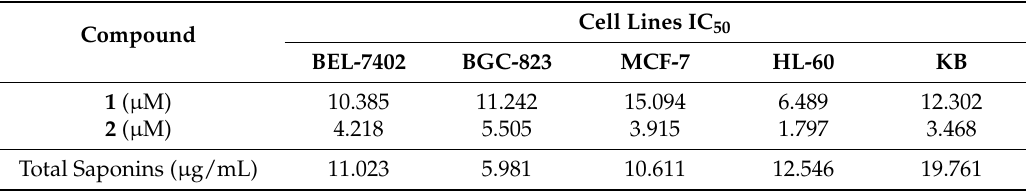
Table 2. Anti-proliferative activity for compounds 1 , 2 and total saponins of C. oleifera against five human tumor cell